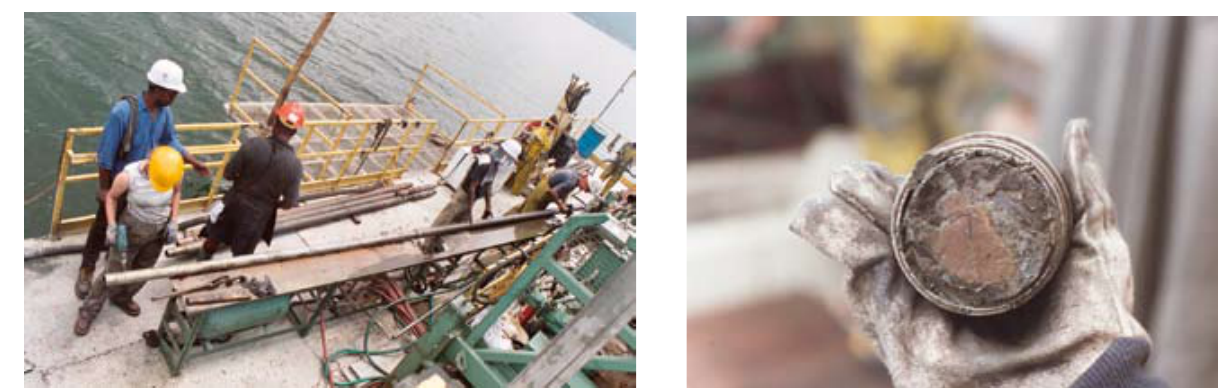
Figure 6. Processing sediment cores. Figure 7. Plant fossil at a section break below 100 mblf.